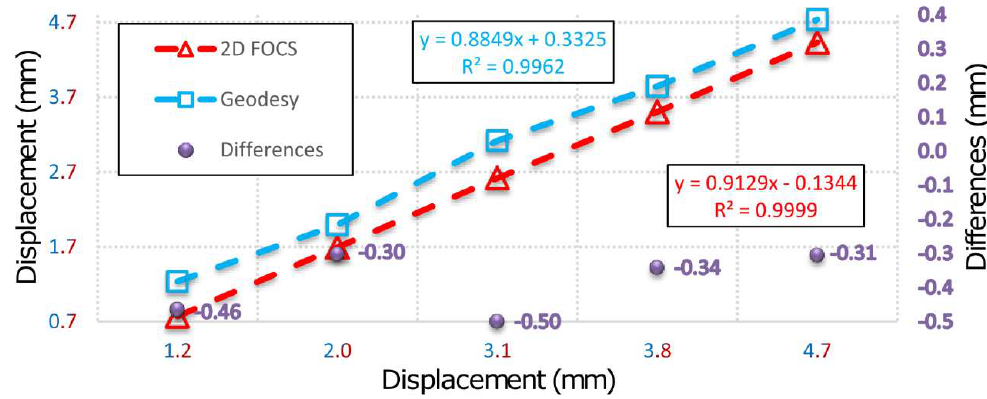
Figure 9. Results and differences for all series of geodetic and 2D deflection sensor measurements for point 7.